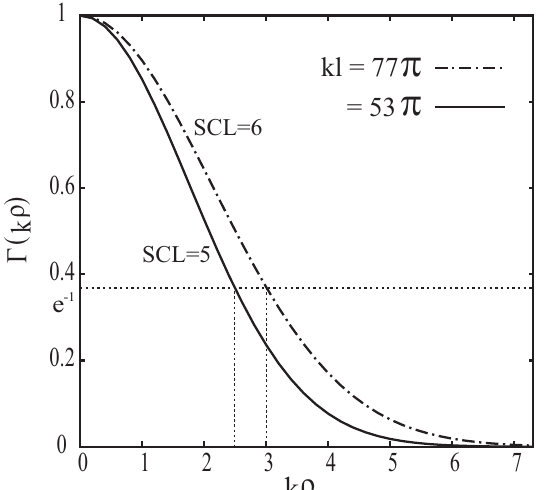
Figure 2. The degree of spatial coherence of incident waves around the